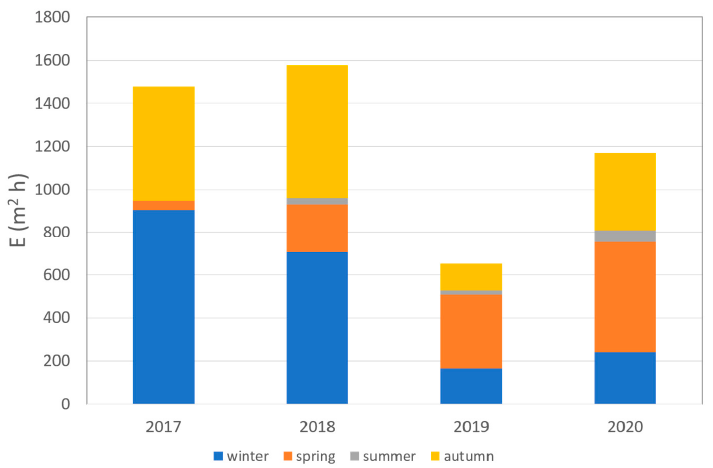
Figure 12. Seasonal distribution of the sea storm energy in the years